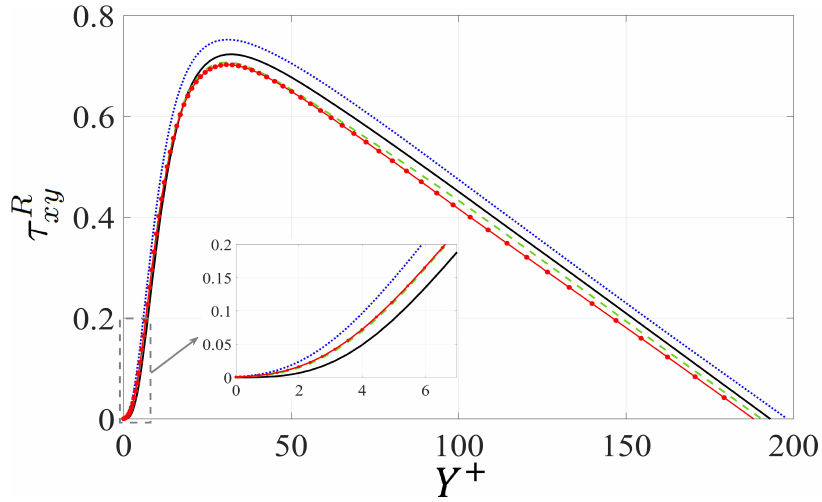
Figure 15. Distribution of the Reynolds stress, τ R xy , next to different permeable walls, plotted up to the centerline of the channel using the same symbols as in Figure 14.